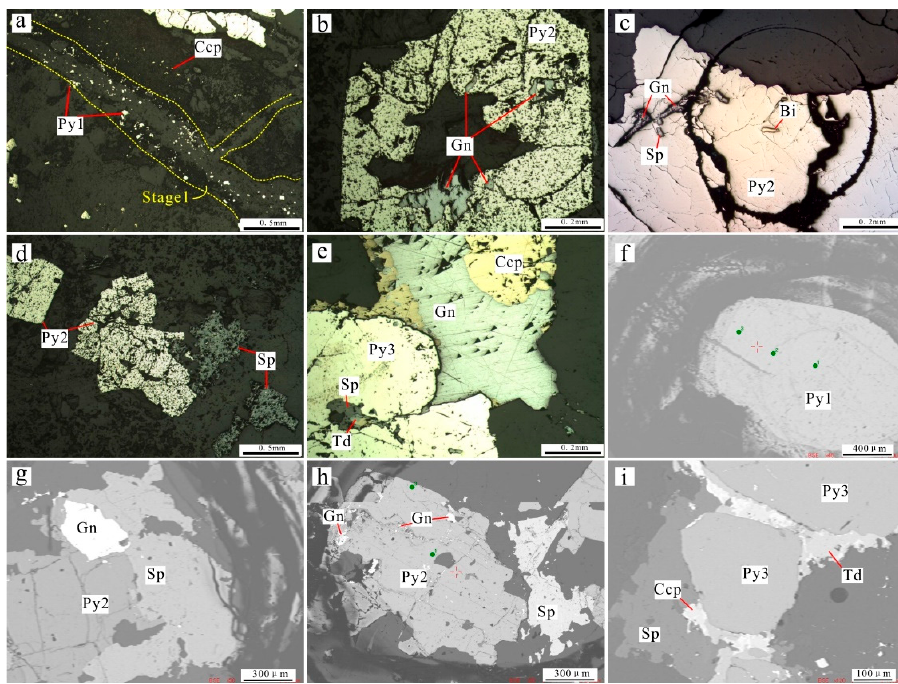
Figure 6. Photomicrographs showing features of metal minerals in Xiajinbao gold deposit: ( a ) Quartz vein (stage 1) containing hypidiomorphic pyrite (Py1); ( b ) Quartz vein (Stage 2) containing idiomorphic pyrite (Py2), which is characterized by pores and fissures; ( c ) Quartz vein (Stage 2) containing hypidiomorphic pyrite (Py2). Bi-bearing fluid inclusions are observed in Py2.; ( d ) Quartz veins (Stage